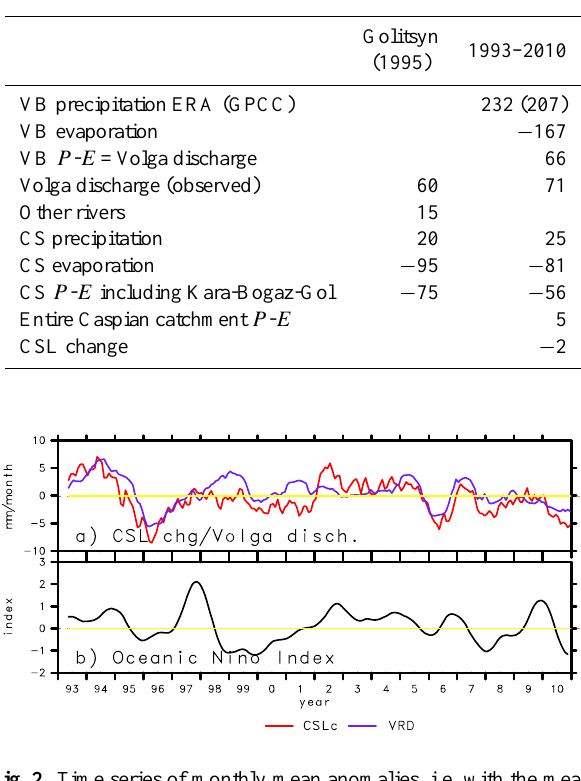
Fig. 2. Time series of monthly mean anomalies, i.e. with the mean annual cycle removed, for (a) the CSL change and the Volga River discharge (values are converted to P - E for the Volga basin catch- ment area and (b) the Ocean Nino Index. A nine month running mean has been applied for